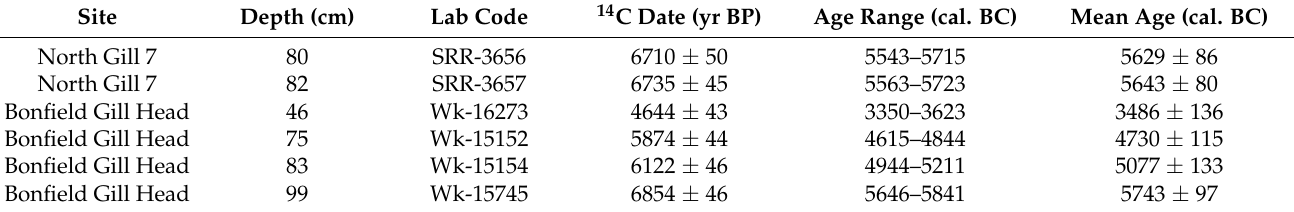
(Figure 1) at a surface altitude of 6 m above sea level. Its pollen diagram was constructed at 4 cm intervals [143] and one level of Late Mesolithic age, dated soon after 5770 ± 50 BP [4609 ± 117 cal. BC; SRR-2699], showed evidence of woodland disturbance and regenera- tion, with ruderal weed grains, increased Corylus and other heliophyte tree percentages and then restoration of deciduous woodland cover. Subsequent pollen analyses of this phase at finer resolution intervals of 5 mm, shown in Figure 2, has clarified its disturbance and regeneration